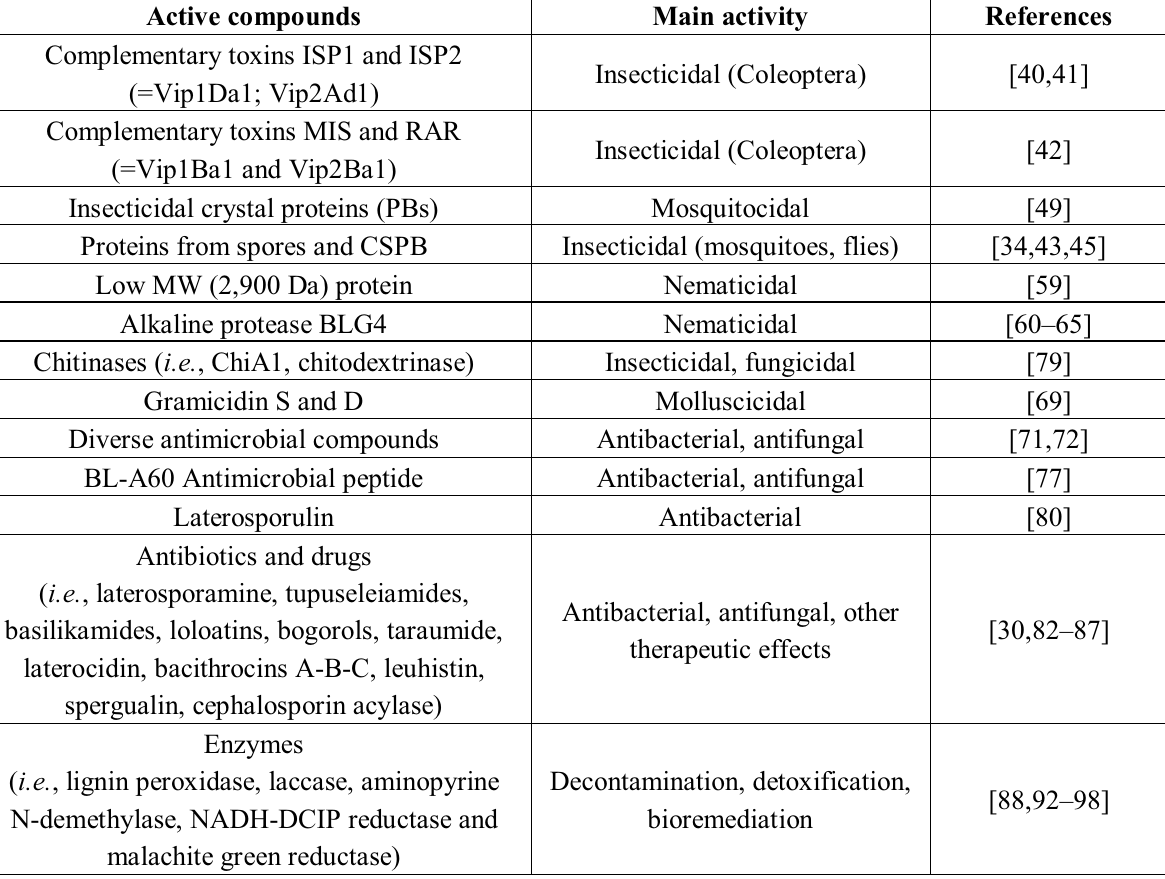
Table 1. Summary of the range of activity of Bravibacillus laterosporus and some of the active compounds produced by different